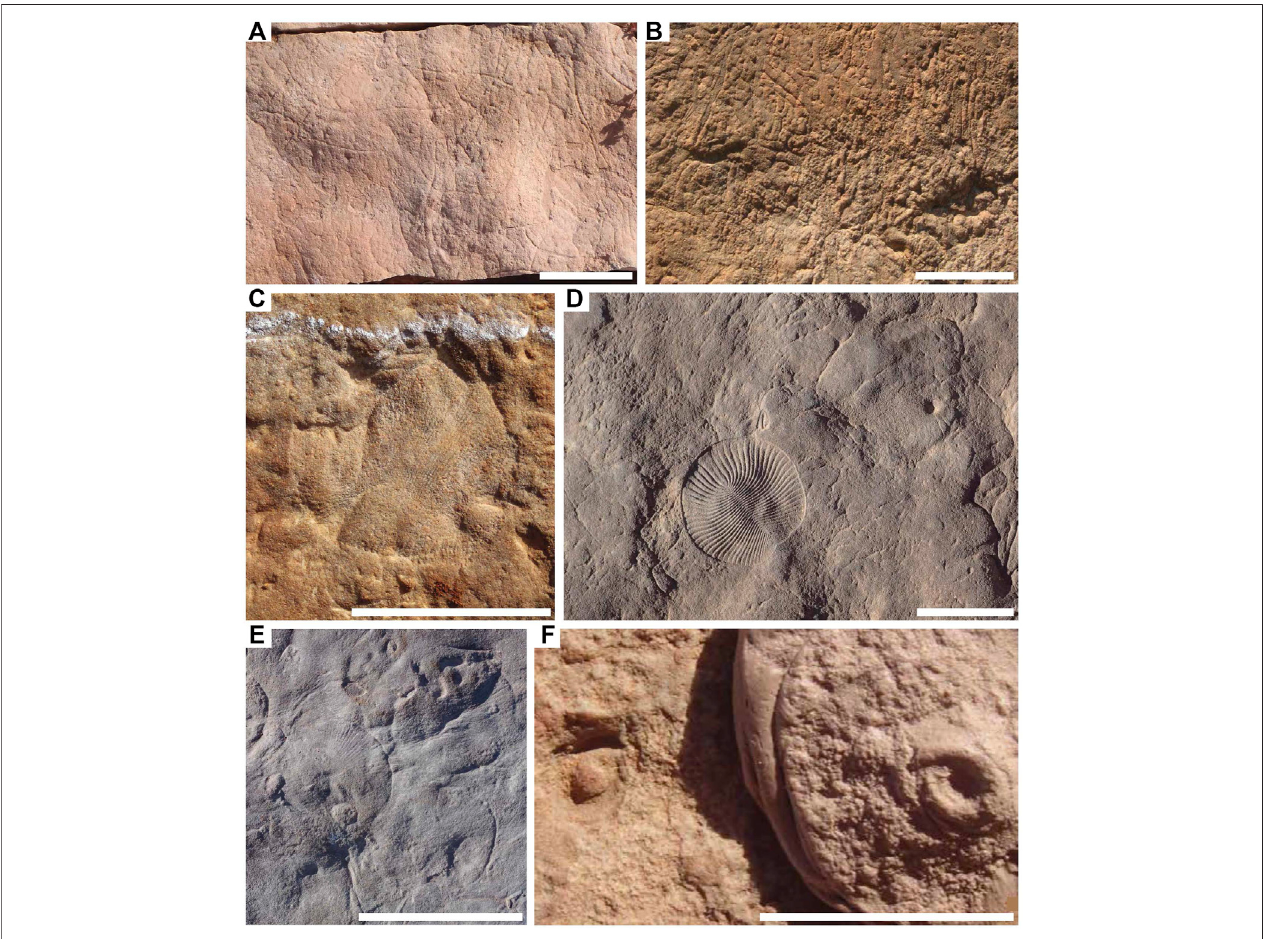
FIGURE 3 | Complex TOS and macrofossils associated with TOS on excavated beds. (A) Complex TOS created by Plexus ricei aggregates on bed P-SNG1. (B) Complex TOS produced by a densely packed population of Funisia dorothea on WS-MAB annex surfaces (C) Dickinsonia body fossil draped over the complex TOS “ groove ” on STC-X bed. (D) Dickinsonia body fossil overlying unde fi ned TOS on bedding plane TB-ARB. (E) Dickinsonia body fossil overlying TOS and associated Dickinsonia footprints on TB-BRW bed. (F) Obamus coronatus fossil (left) and putty mold (right), showing that the organism was embedded within the TOS on LV- Fun bed. Scale bars = 5 cm.